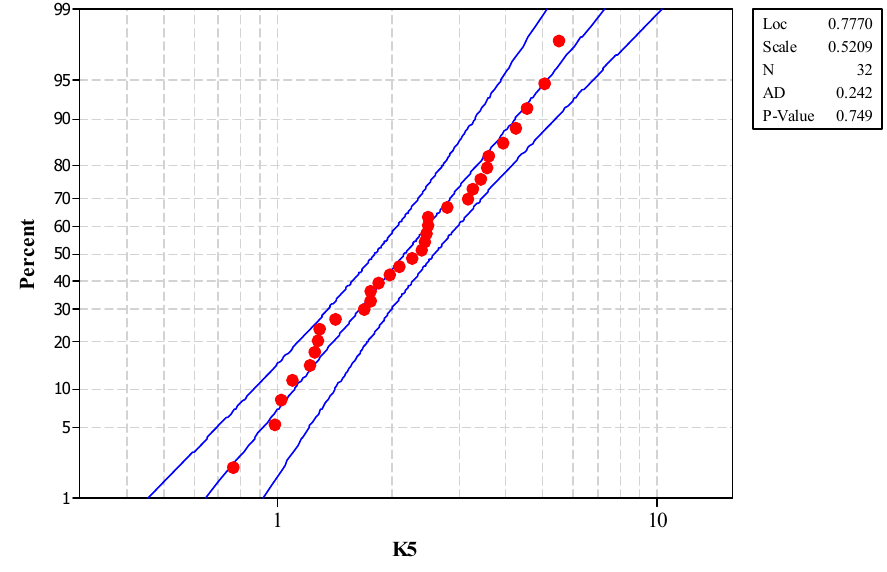
Figure 2. Lognormal probability plot of (cid:101) k 5